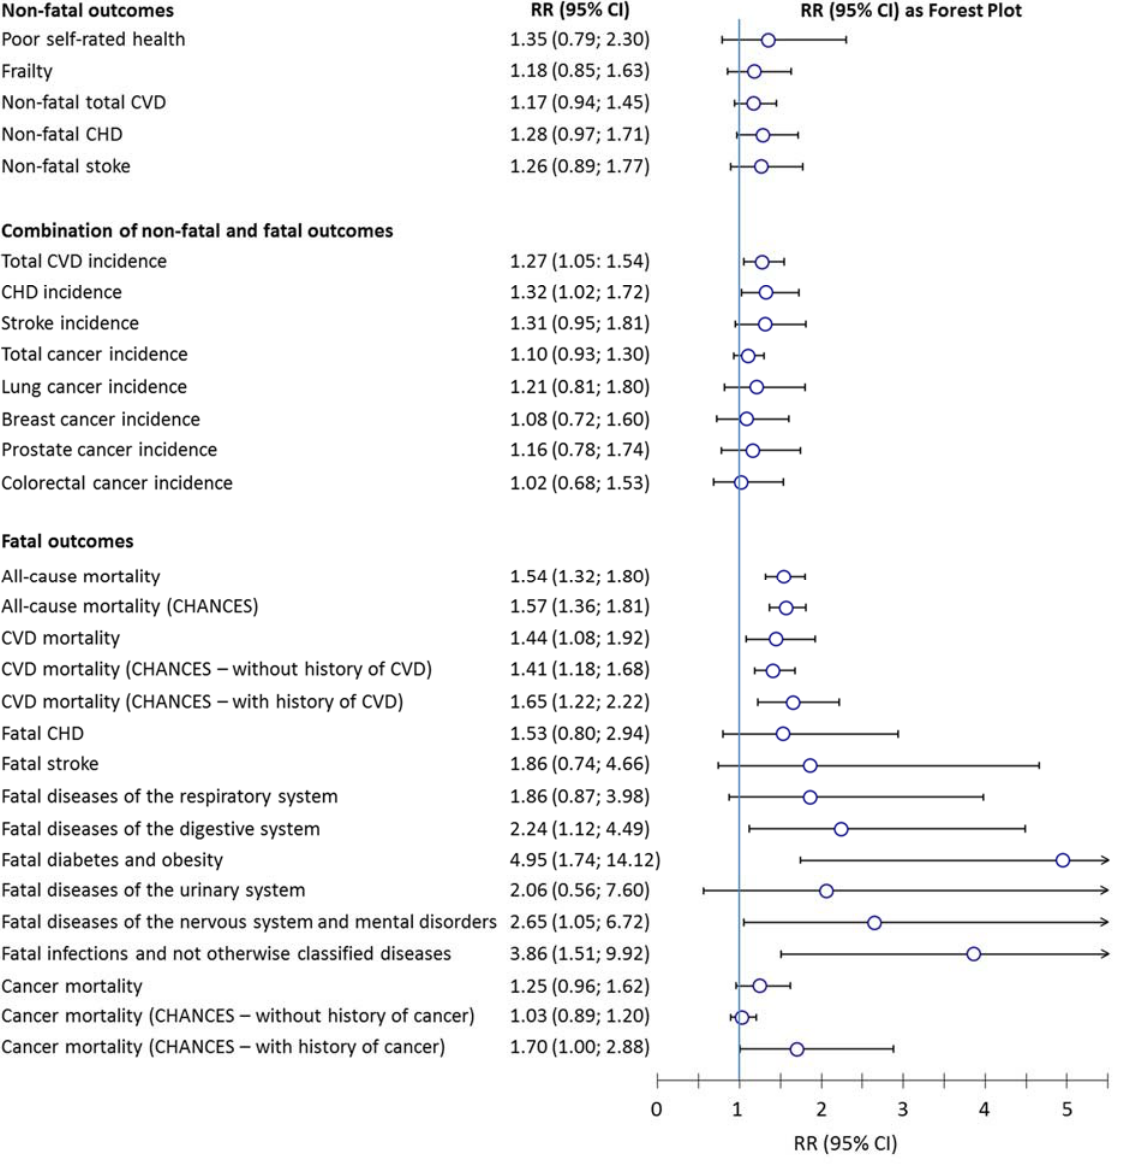
Figure 1. Association of lowest vs. highest 25-hydrodroxyvitamin D category 1 with different prospective outcomes in the ESTHER study (if not stated otherwise). CHANCES, Consortium on Health and Ageing: Network of Cohorts in Europe and the United States; CHD, coronary heart disease; CI, confidence interval; CVD, cardiovascular disease; RR, risk ratio; 1 25(OH)D < 30 nmol L − 1 ( i.e. , vitamin D deficiency) vs. 25(OH)D ≥ 50 nmol L − 1 ( i.e. , vitamin D sufficiency) or bottom quintile/quartile vs. top quintile/quartile of 25(OH)D